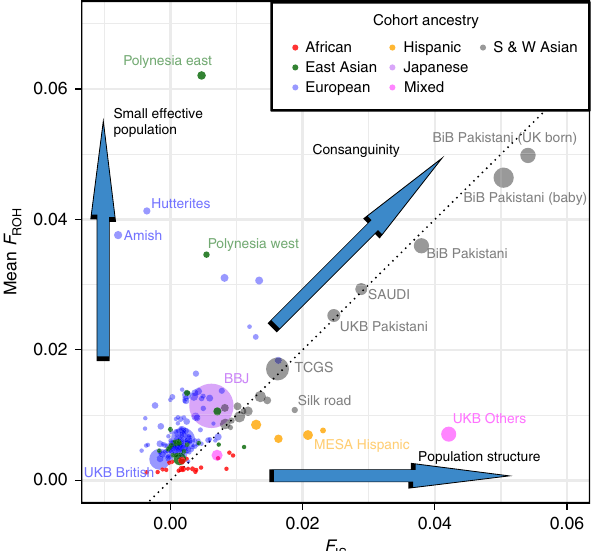
Fig. 2 Mean F ROH and F IS for 234 ROHgen sub-cohorts. Each cohort is represented by a circle whose area is proportional to the approximate statistical power ( N σ 2 F ) contributed to estimates of β F . Mean F ROH can ROH ROH be considered as an estimate of total inbreeding relative to an unknown base generation, approximately tens of generations past. F IS measures inbreeding in the current generation, with F IS = 0 indicating random mating, F F 46 . In IS > 0 indicating consanguinity, and IS < 0 inbreeding avoidance cohorts along the y -axis, such as the Polynesians and the Anabaptist isolates, autozygosity is primarily caused by small effective population size rather than preferential consanguineous unions. In contrast, in cohorts along the dotted unity line, all excess SNP homozygosity is accounted for by ROH, as expected of consanguinity within a large effective population. A small number of cohorts along the x -axis, such as Hispanic and mixed-race groups, show excess SNP homozygosity without elevated mean F ROH , indicating population genetic structuring, caused for instance by admixture and known as the Wahlund effect. A few notable cohorts are labelled.